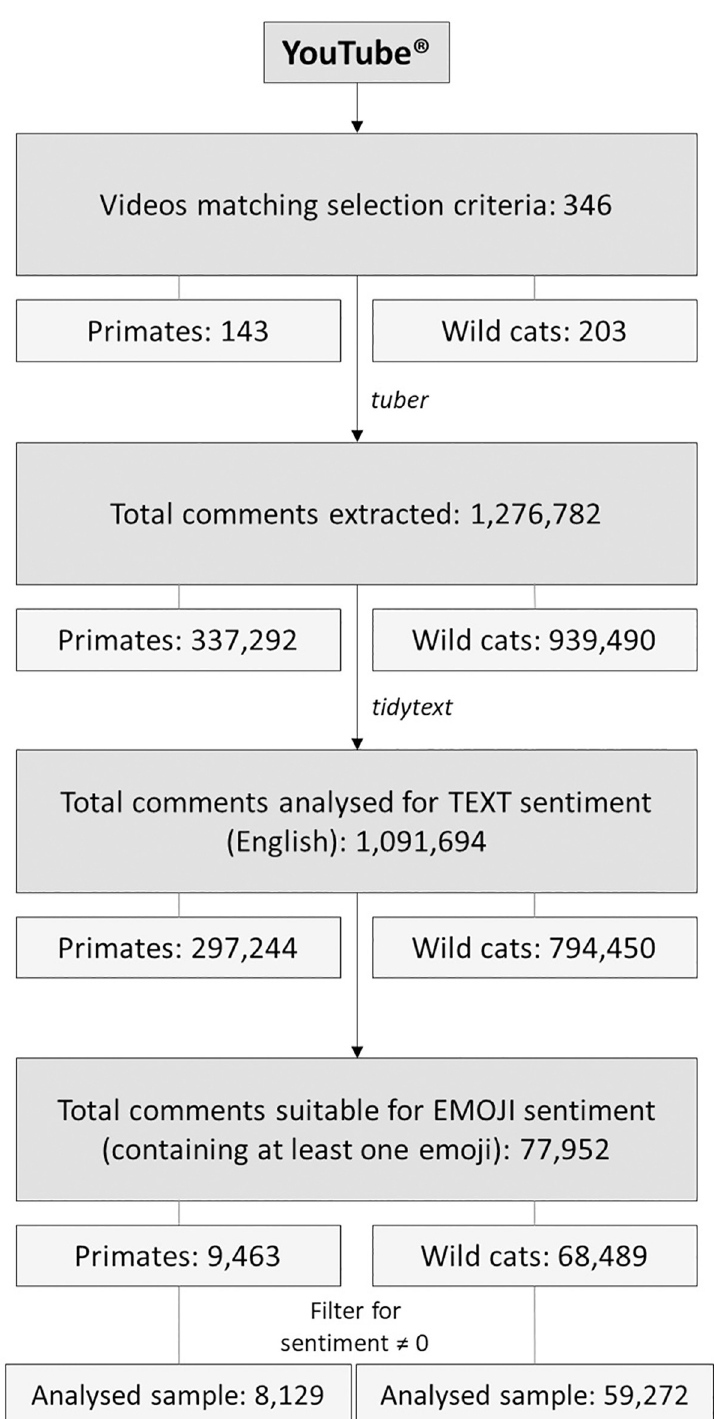
Fig 1. Methodological framework for comment extraction and analysis. Methodological framework for comment extraction and analysis across the 346 YouTube 1 videos published from 2006 to 2019, sourced in accordance with pre- determined selection criteria. Only comments extracted written in English, or containing terms identified by the sentiment software employed, were analysed for text sentiment. Likewise, only comments containing at least one emoji were analysed for emoji sentiment. Filters were applied to ensure comments analysed for emoji sentiment contained at least one emoji and had an associated positive or negative sentiment score.